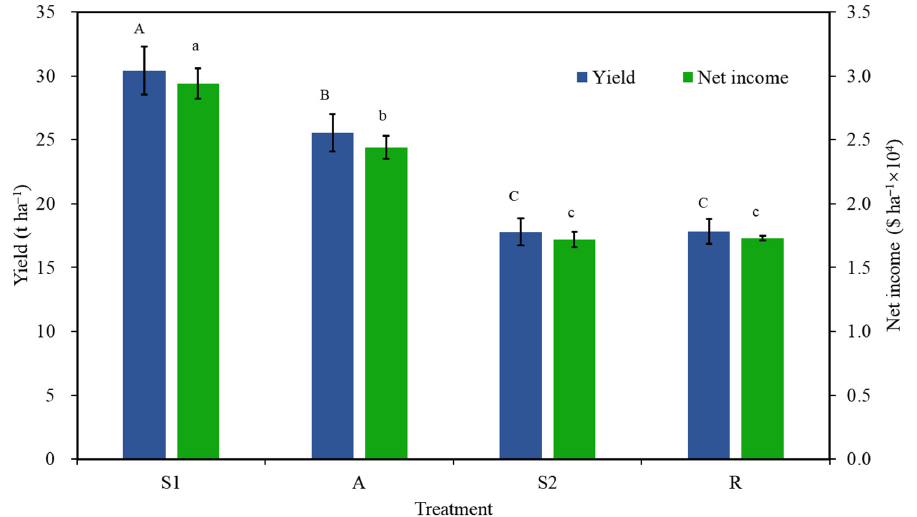
Figure 11. Comparison of yield and net income of different treatments in two seasons. (The error bars show the standard deviation of three replicates. The different uppercase letters indicating significant difference of yield under different treatments at p < 0.05, while the lowercase letters indicating significant difference of net income under different treatments at p < 0.05).